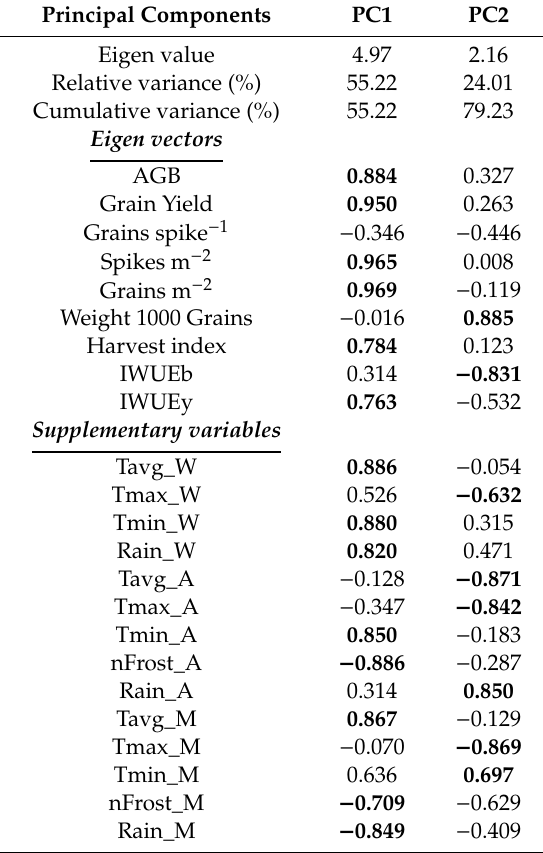
Table 8. Eigen values, relative and cumulative percentage of total variance, and correlation coe ffi cients for wheat traits with respect to the two principal components (PC1 and